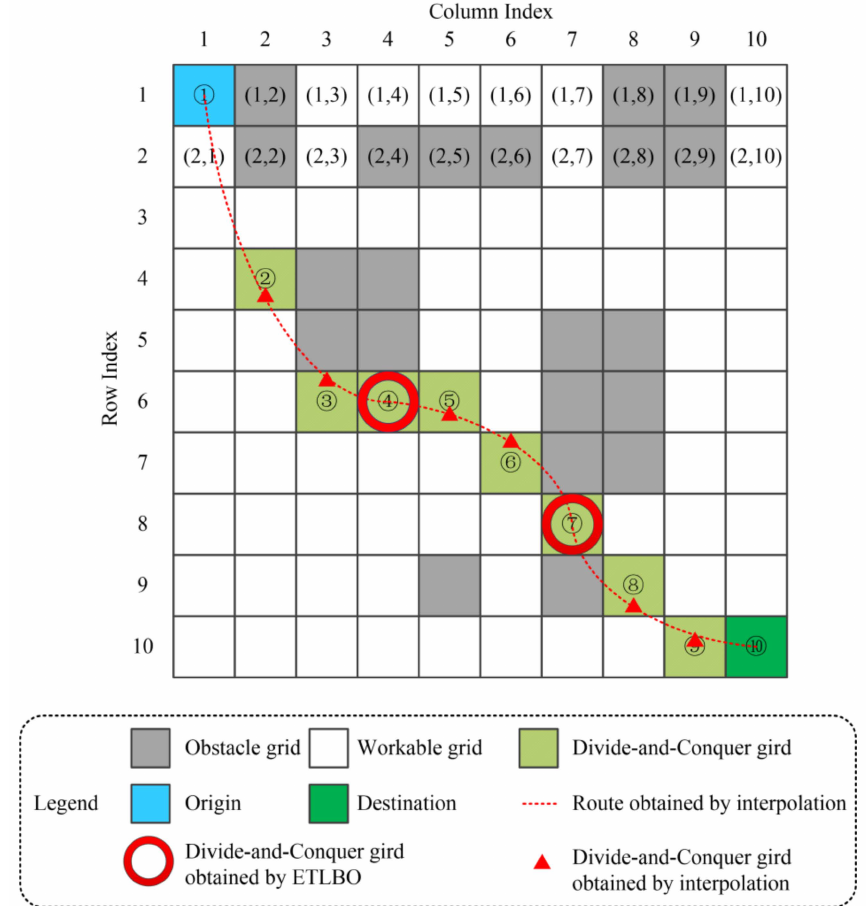
Figure 4. Schematic diagram of interpolation